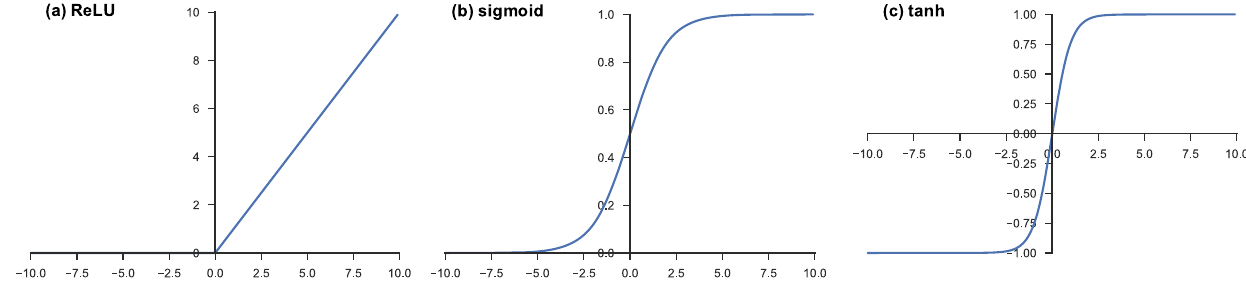
Fig. 5 Activation functions commonly applied to neural networks: a rectified linear unit (ReLU), b sigmoid, and c hyperbolic tangent